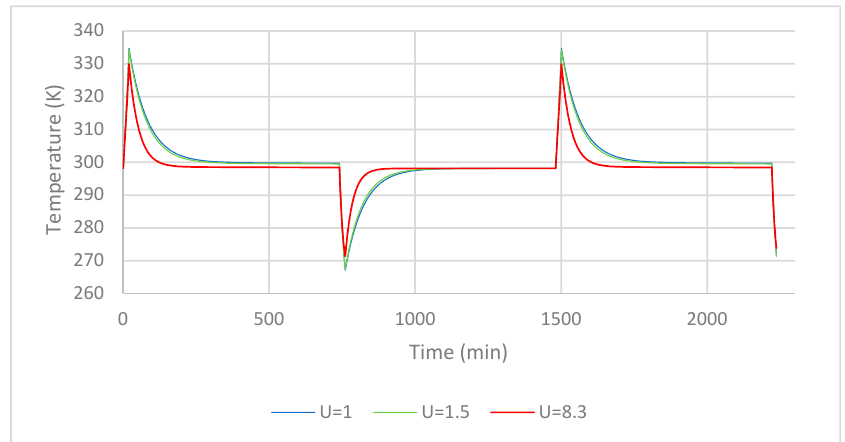
Table 6. Efficiency system for the second configuration varying the Volume of the tank.